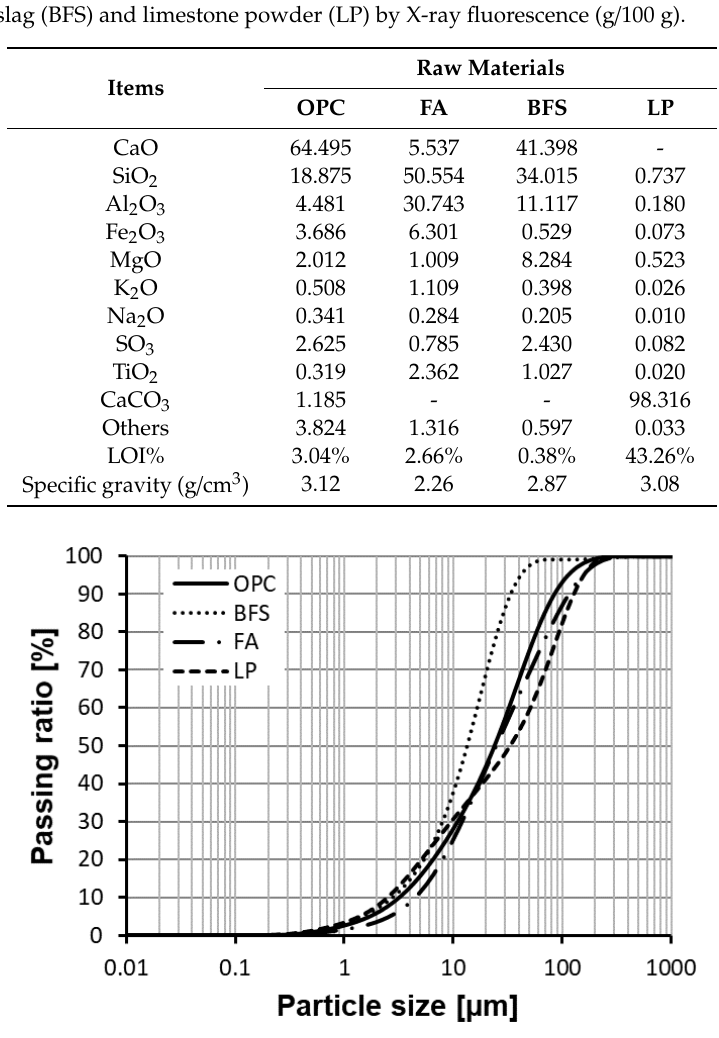
Table 1. Chemical composition of ordinary Portland cement (OPC), fly ash (FA), ground granulated